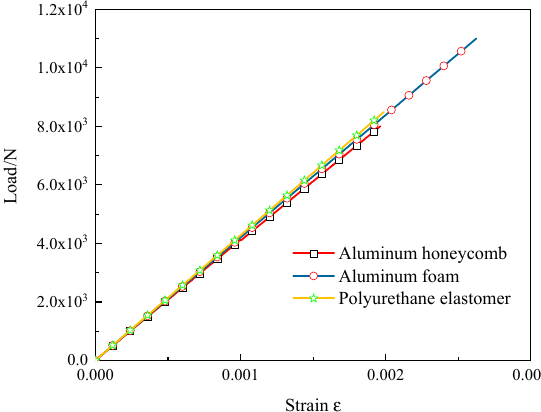
Displacement/mm Aluminum honeycomb Aluminum foam Polyurethane elastomer Figure 5. Load–displacement curves of the three composite sandwich laminated box beams.